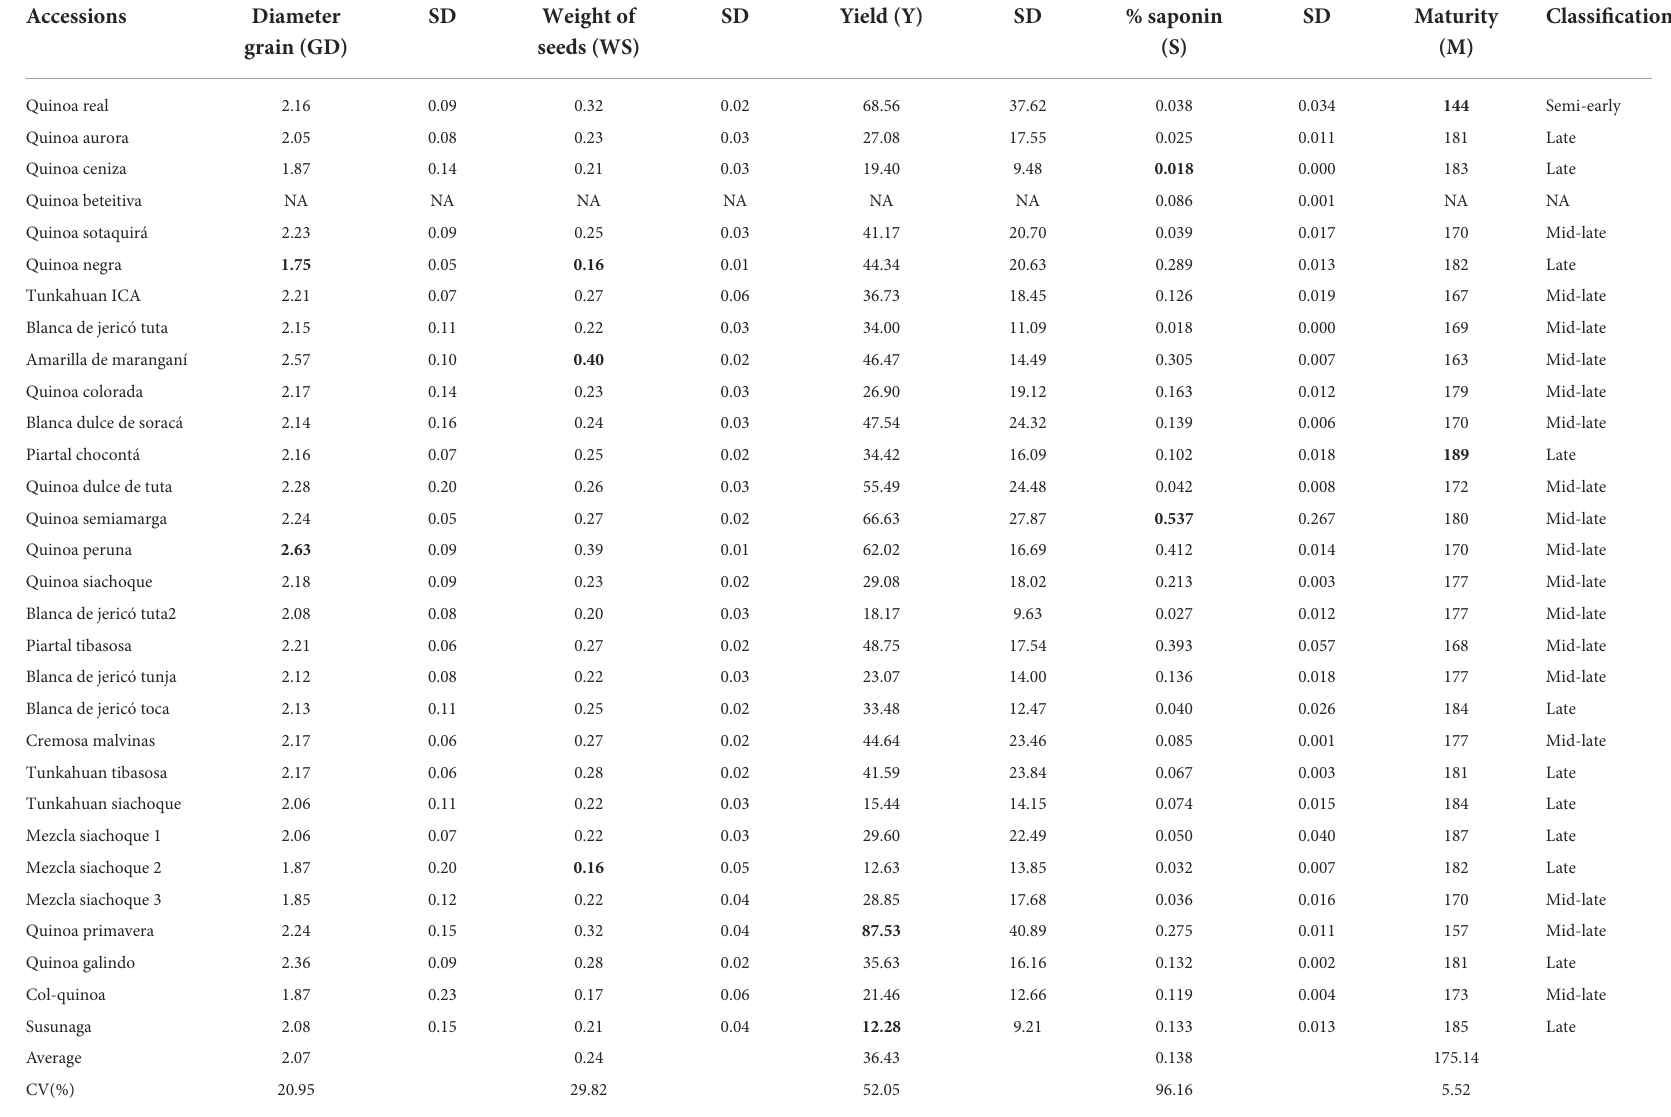
TABLE 4 Averages, coefficients of variation and standard deviation (SD) for the quantitative variables evaluated in the quinoa accessions. Accessions Diameter Weight